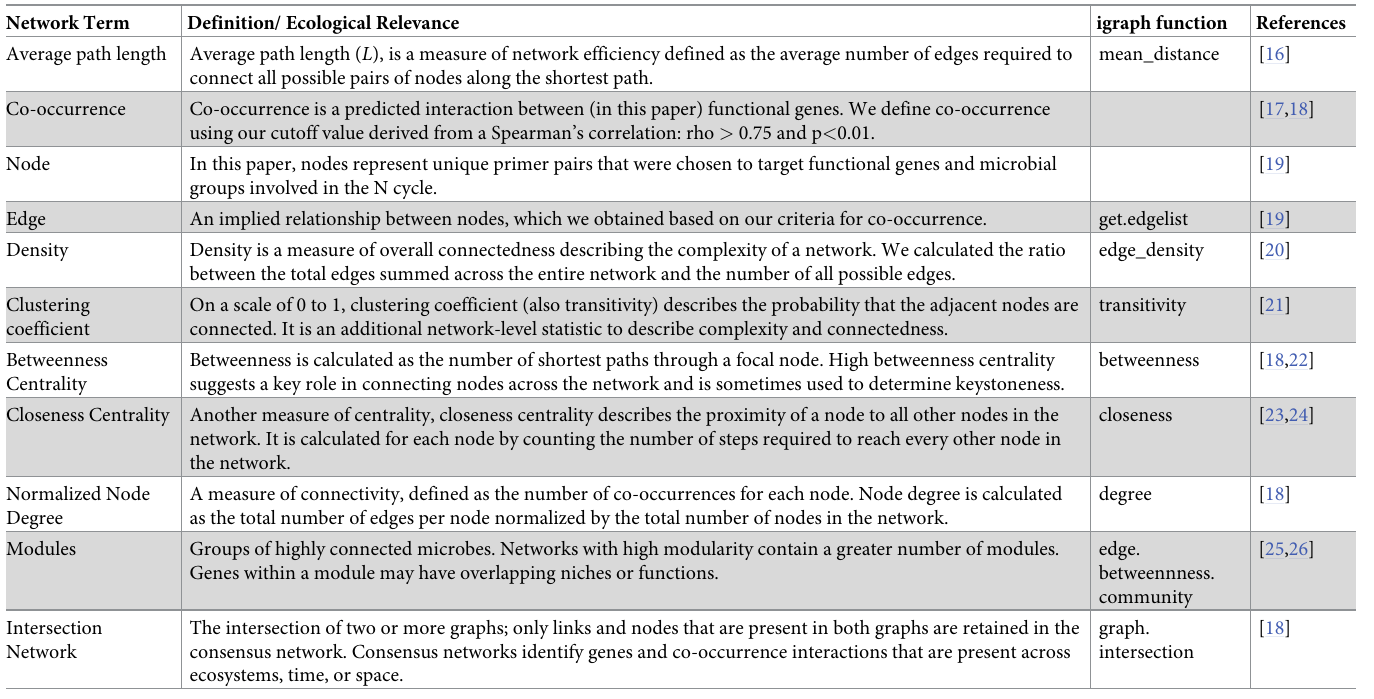
Table 1. Definition of network terms used in the present